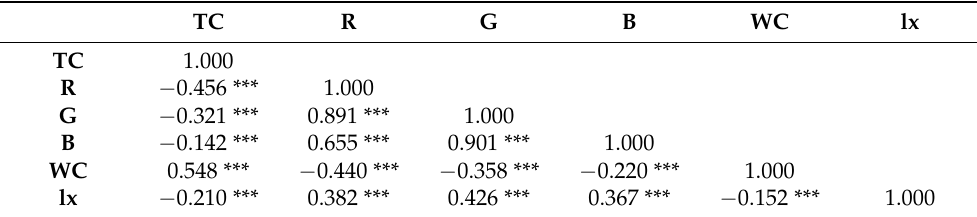
Table 1. Pearson correlation coefficient table of the TS soil components. TC R G B WC lx